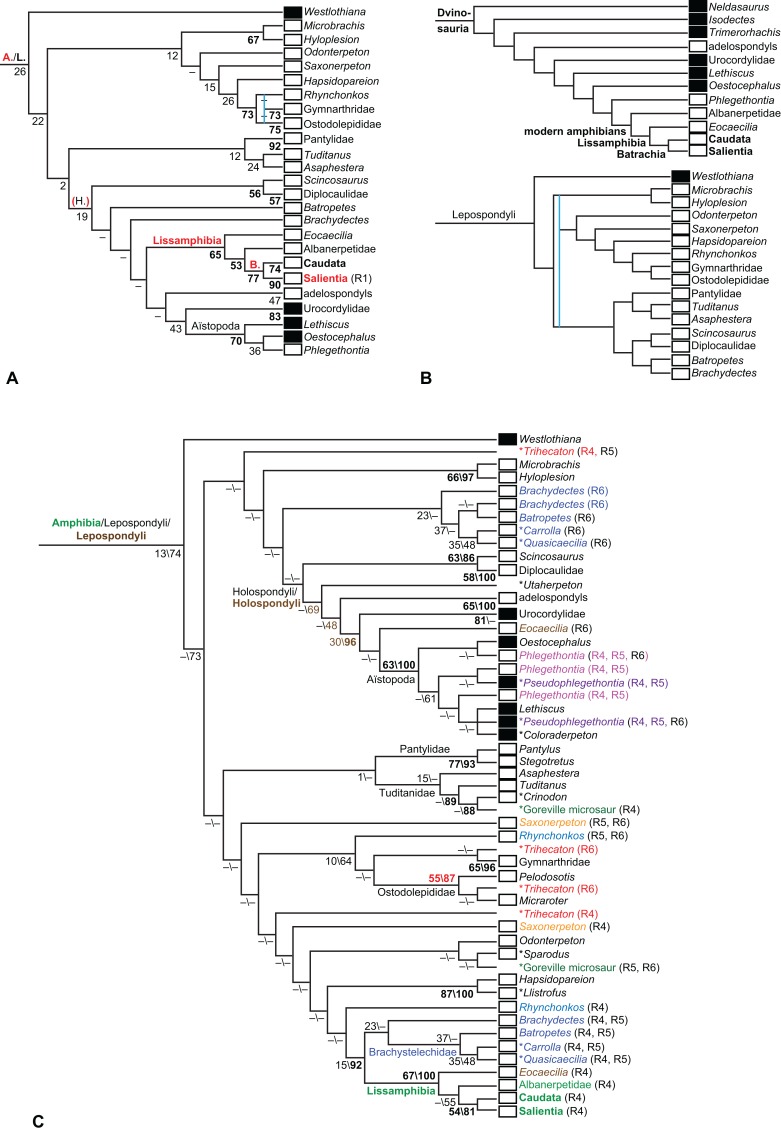
The relationships of “lepospondyls” in our analyses, and the distribution of the supratemporal bone.Various named clades are collapsed. Filled rectangles indicate presence of the supratemporal (state 2 or lower of ch. 32—PAR 2/POSFRO 3/INTEMP 1/SUTEMP 1; see App. S1), empty rectangles its absence (state 3 or 4); the absence of a rectangle indicates missing data. A., Amphibia; B., Batrachia; H., Holospondyli; L., Lepospondyli. (A) Topology found in Analyses R1 and R3. Numbers below internodes are BPO; compare unsupported nodes to Fig. 18. (B) Topology found in R2. (C) Topology found in R4–R6. Numbers are BPE\PP; compare unsupported nodes to Figs. 19 and 20. Numbers in red or brown depend on *Trihecaton or Eocaecilia, respectively, not being members of the clades in question; the opposite holds for clade names in color.